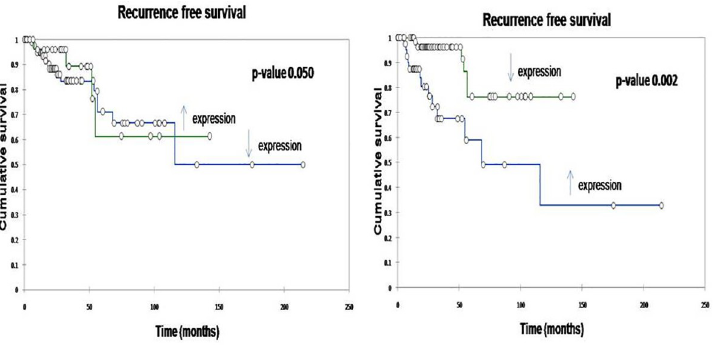
Fig 2. Recurrence free survival (RFS) of patients by Kaplan Meier method based on their microRNA expression (a) miR-18a (b) miR-182. Overexpression of miR-18a was associated with improved RFS (p-value 0.050). Underexpression of miR-182 was associated with improved RFS (p-value 0.002).